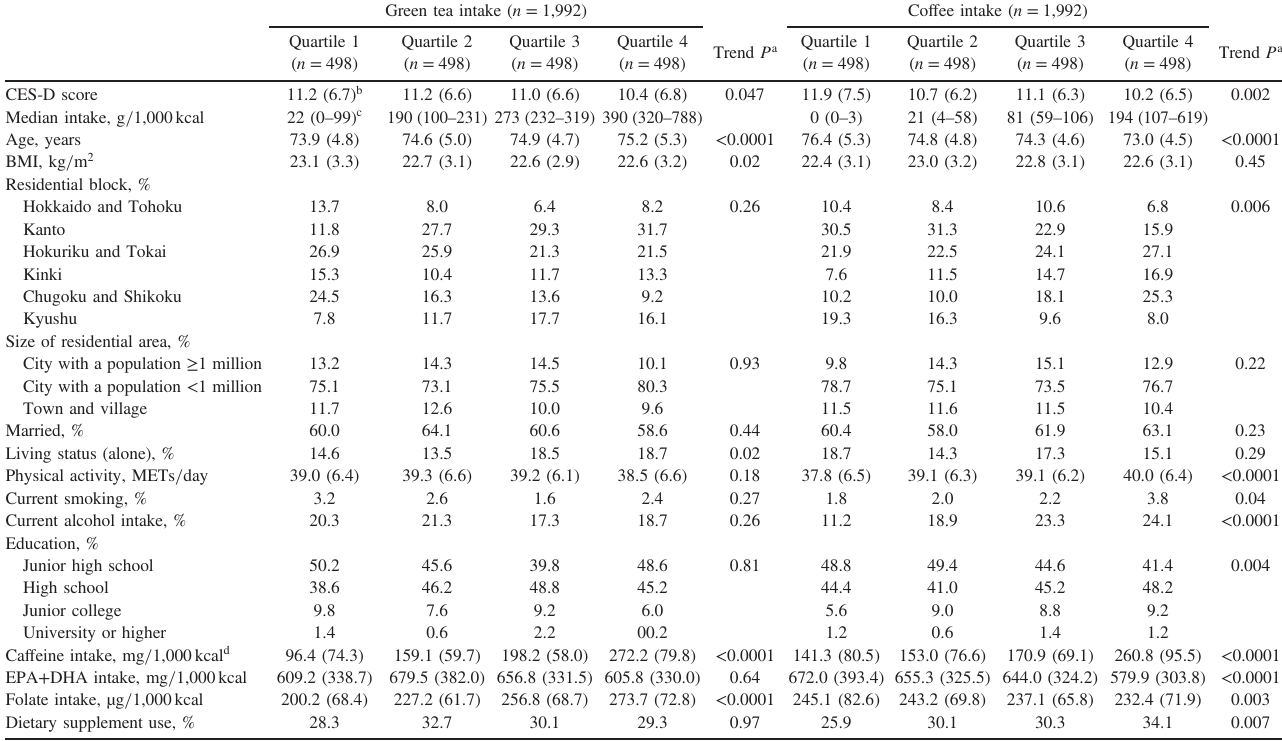
Table 1. Characteristics of study participants according to green tea and co ff ee intake: elderly Japanese women ( n = 1,992)